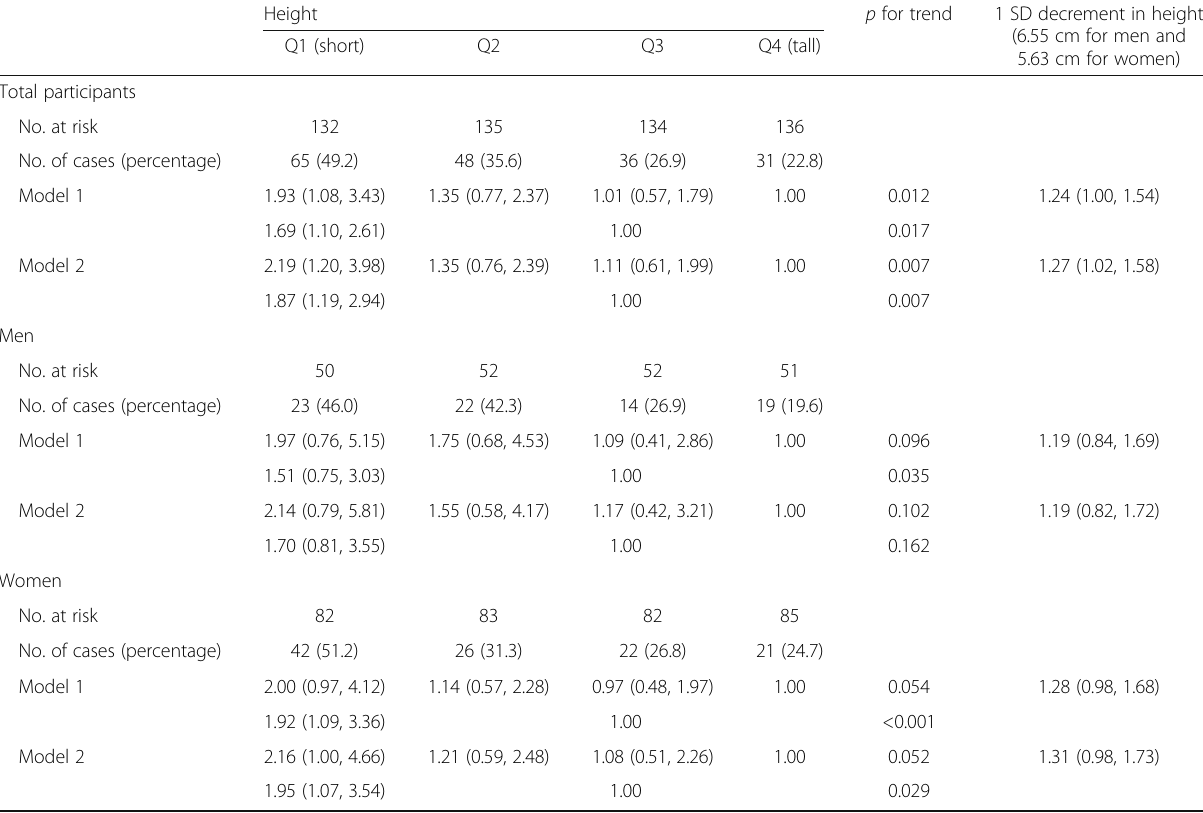
Model 1: adjusted only for sex and age. Model 2: further adjusted for body mass index, systolic blood pressure, alcohol consumption (never drinker, former drinker, current drinker [<23, 23 – 45, 46 – 68, and ≥ 69 g/week]), smoking status (never smoker, former smoker, current smoker), history of stroke, HDL-cholesterol, triglycerides, HbA1C, and serum creatinine. Reduced maximum voluntary tongue pressure against the palate is defined as the lowest tertile of the study population (<26.5 kPa for men and <24.1 kPa for women). Height values for men are <158.0 cm for Q1, 158.0 – 161.8 cm for Q2, 161.9 – 166.5 cm for Q3, and >166.5 cm for Q4 and for women are <145.0 cm for Q1, 145.0 – 148.9 cm for Q2, 149.0 – 152.7 cm for Q3, and >152.7 cm for